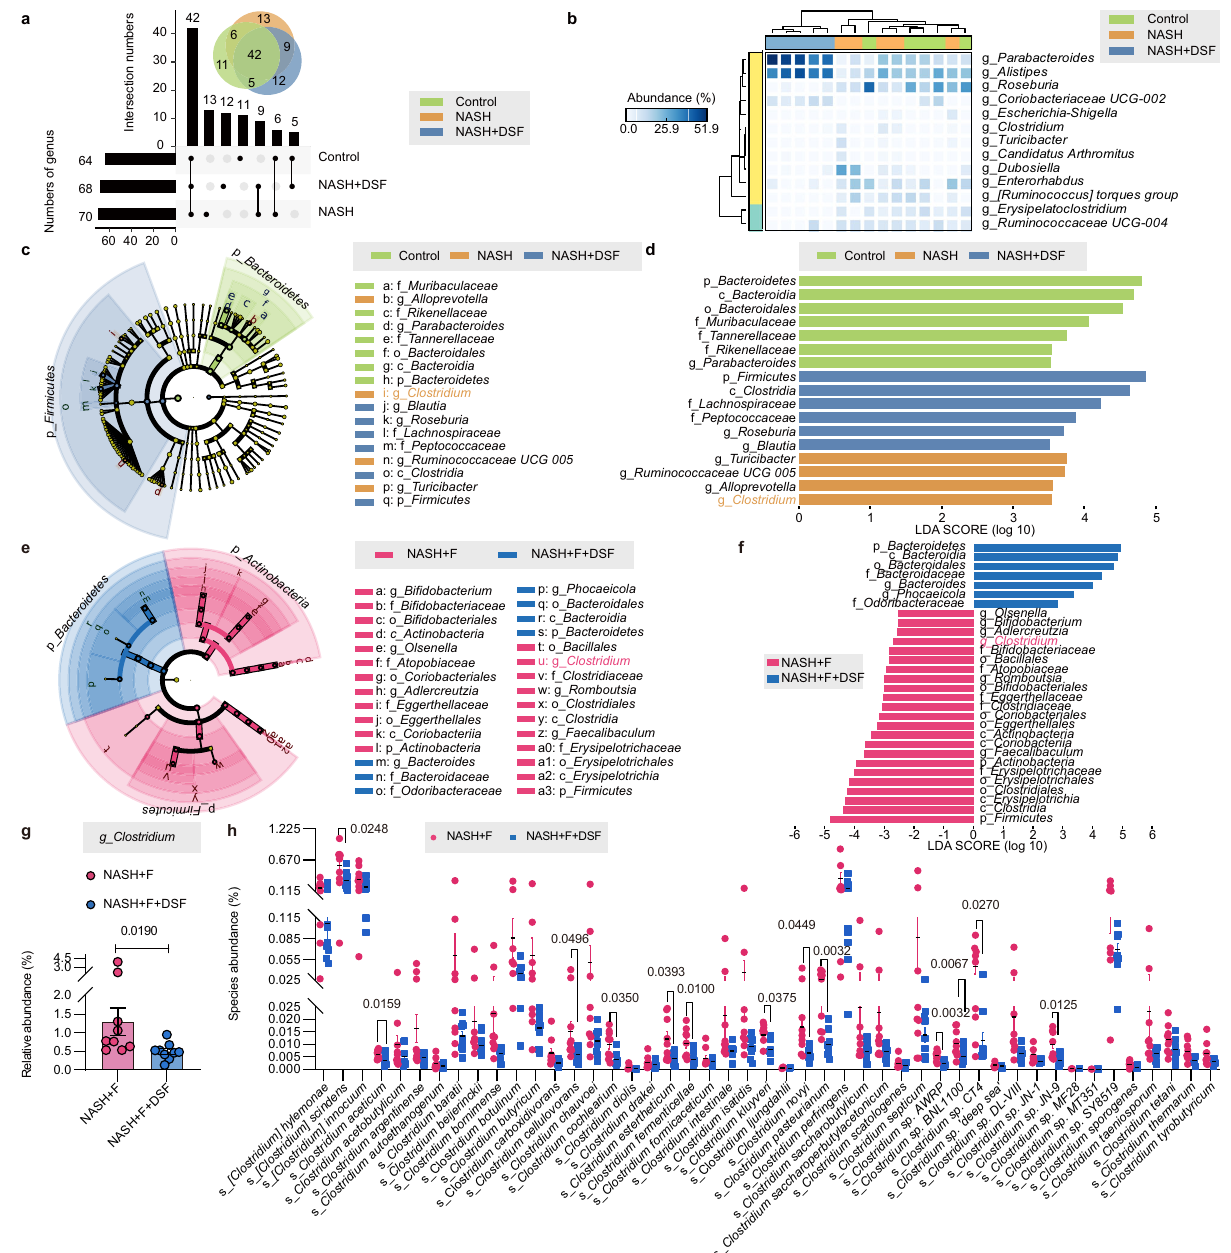
Fig. 3 | DSF modulates the gut microbiota and apparently reduces the abun- dance of Clostridium . a – d 16S rRNA gene sequencing analysis in fecal bacterial DNA from control, NASH and NASH+DSF mice was performed. n=5 individuals/ group. a In genus level, Upset and Venn diagram of the ASVs in control, NASH and NASH+DSF mice. b Heatmap of selected differentially abundant features of con- trol, NASH and NASH+DSF mice (FDR-adjusted P <0.05, LinDA). c , d Cladograms generated by LEfSe depicting taxonomic association between microbiome com- munities from control, NASH and NASH+DSF mice (LDA>3.5). Green, orangeand blue bars indicate taxa predominant in control, NASH and NASH+DSF mice, respectively. e – h Metagenomic sequencing analysis in fecal bacterial DNA from NASH+F and NASH+F+DSF mice was performed. n =9 individuals/group.